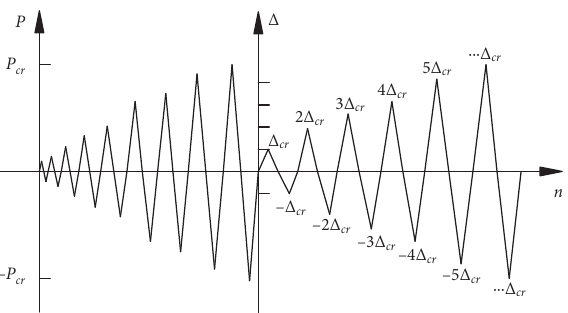
Figure 4: Horizontal loading method.